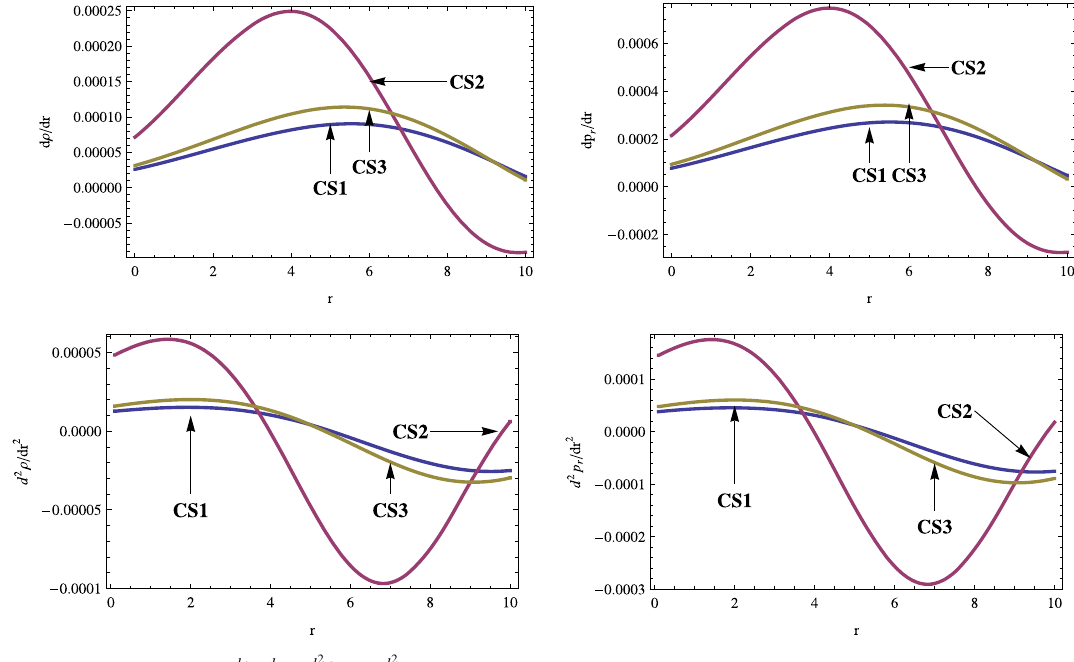
Fig. 9 Variations of derivatives of d ρ